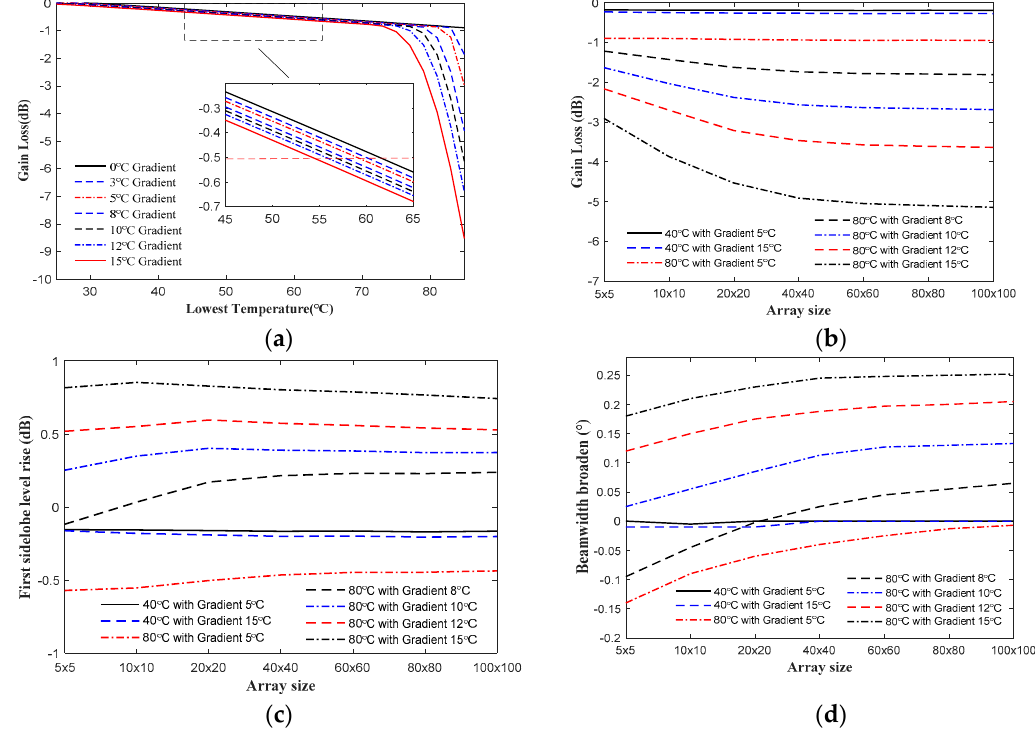
Figure 9. ( a ) Gain-loss versus the temperature gradient; ( b ) gain-loss versus the antenna size; ( c ) first sidelobe level rise; ( d ) broadening of 3 dB beamwidth.